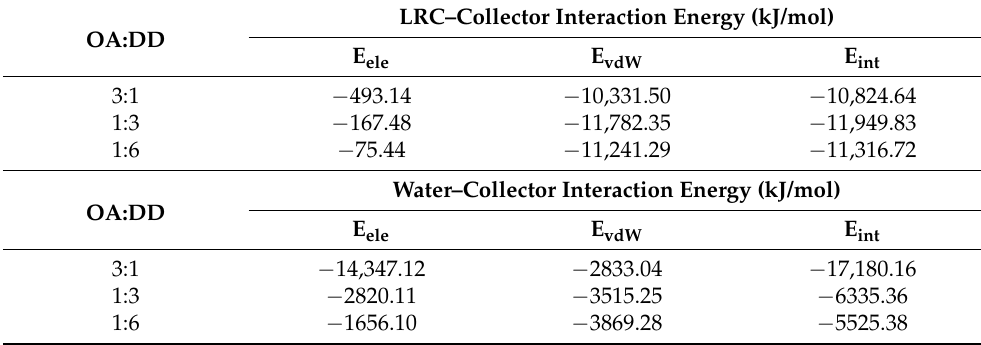
Table 3. The interaction energy between collectors and water and between collectors and the LRC model after equilibrium.